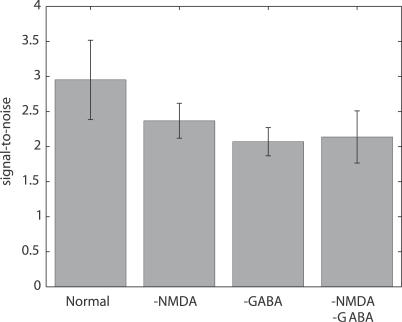
Signal-to-Noise Ratio of a Measure Related to the Blood Oxygenation Level–Dependent SignalWe computed the mean and standard deviation of averages of the synaptic currents of the selective pool over the whole simulation period of a persistent condition simulation. The mean of the spontaneous baseline condition was subtracted. We conducted 1,000 simulated trials. The signal-to-noise ratio is calculated by division of the mean synaptic current by the standard deviation measured using 1,000 trials. The error bars indicate an estimate of the standard deviation measured over 20 epochs containing 50 trials each. A modulation of the synapses shown as −NMDA and −GABA corresponds to a reduction of 4.5% and 9% in their conductances, respectively.